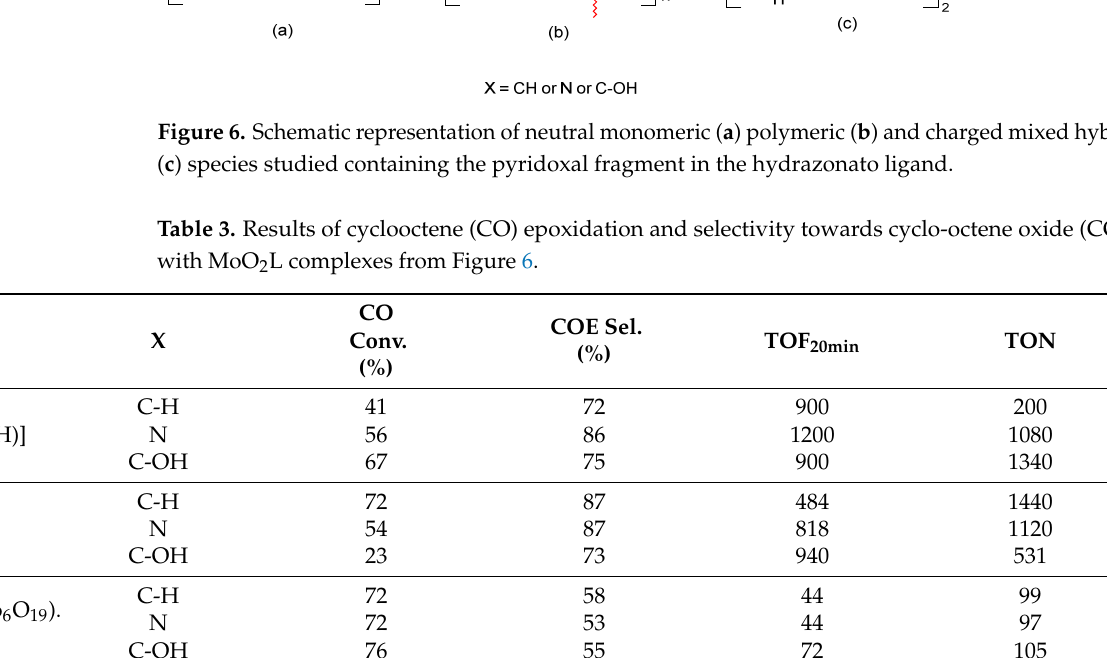
0.25% Mo loading vs. substrate 80 °C/6 h/2 eq TBHP.